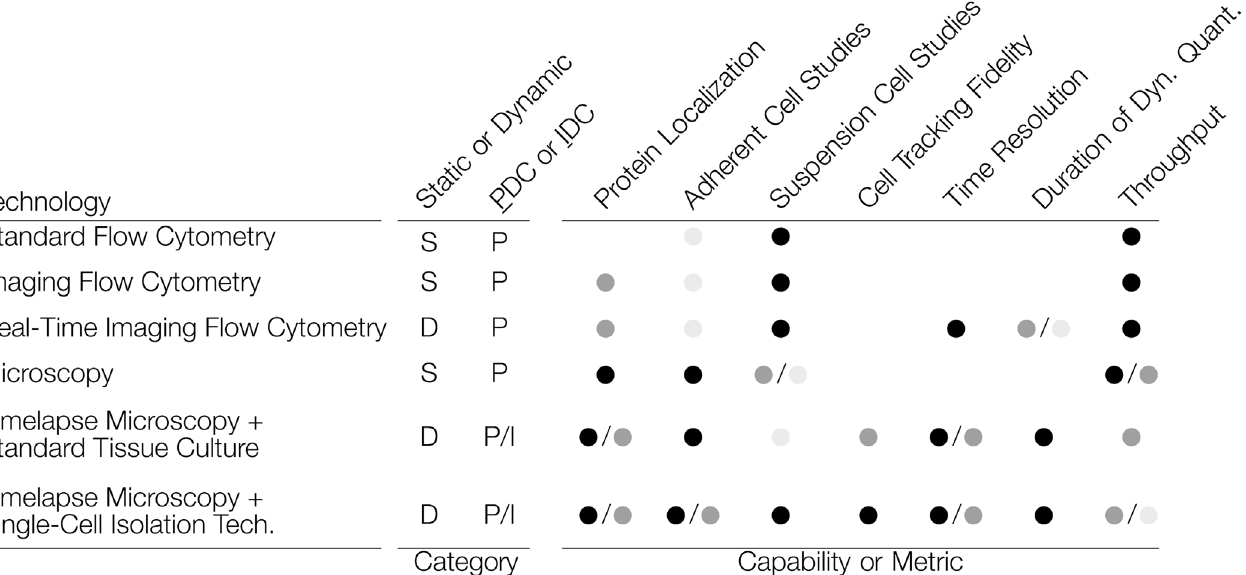
Fig 1. Comparison of general approaches that enable fluorescence-based cytometry. The categories and capabilities of each are roughly assessed. Capability Key: ● = High, ● = Medium, ● = Low, (blank) = not signi fi cant.